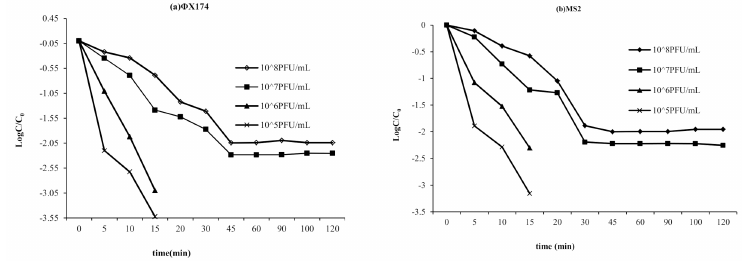
Figure 3. ( a ) Φ X174 and ( b ) MS2 concentrations against adsorption (expressed as logC/C 0